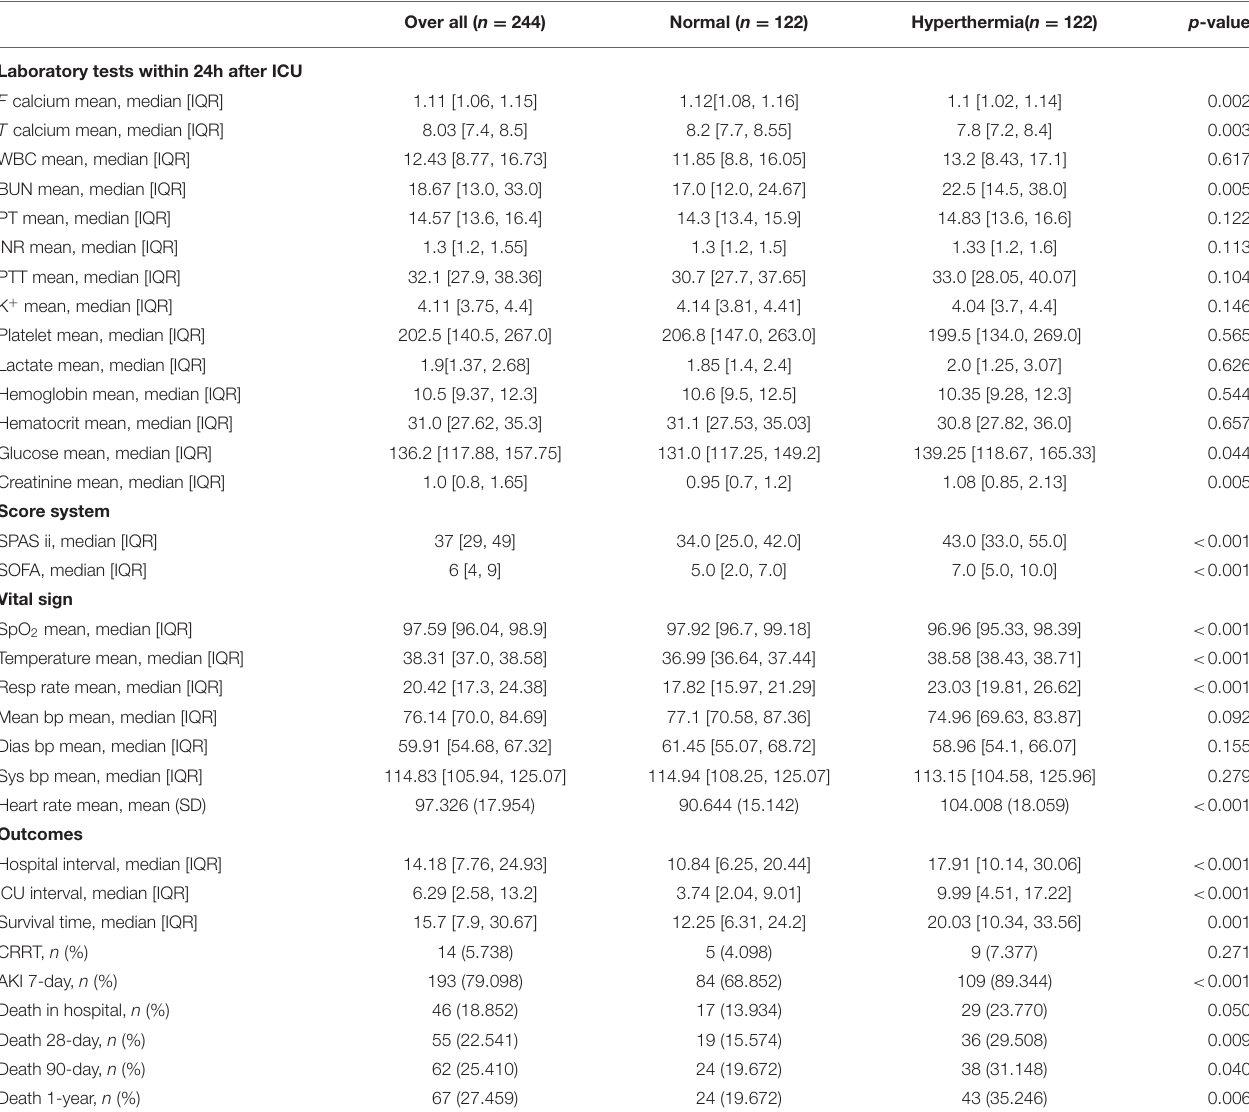
TABLE 4 | Post-PSM matched between hyperthermia and normal